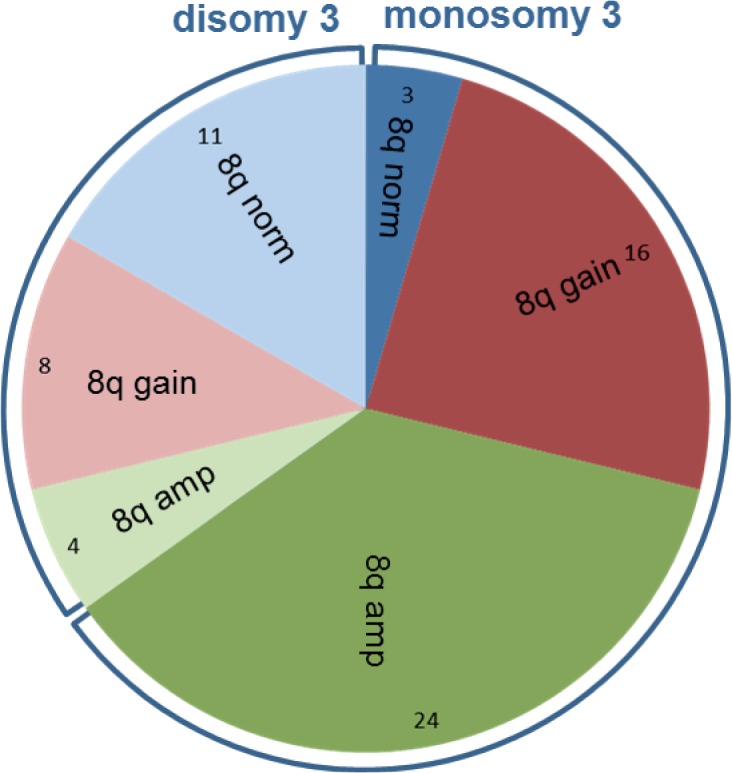
Non-random distribution of monosomy 3 and chromosome 8 aberrations.In 40 (61%) of the 66 UM monosomy 3 and 8q aberrations occur together. Non-random distribution is even stronger for 8q amplification and monosomy 3, as monosomy 3 is present in 24 (86%) of 28 UM with 8q amplification.